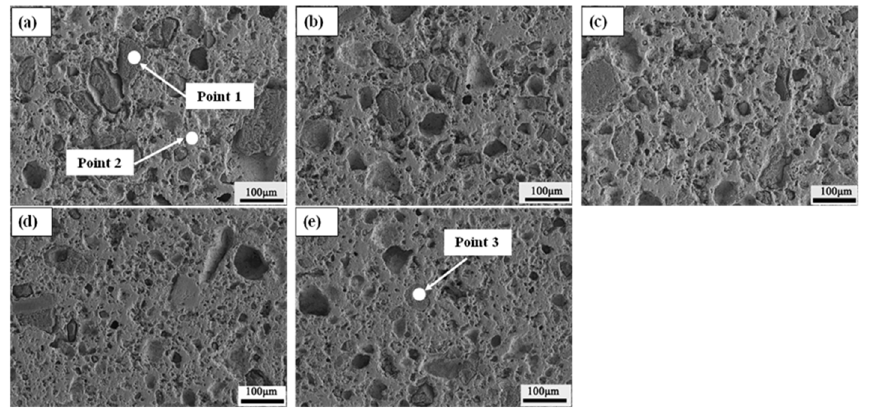
Figure 13. SEM images and EDS analysis of sample of Fe 2 O 3 -MgO-CaO. ( a ) 0% ( b ) 25% ( c ) 50% ( d ) 75% ( e ) 100%. Table 7. EDS analysis of Fe 2 O 3 -MgO-CaO sample before reduction.